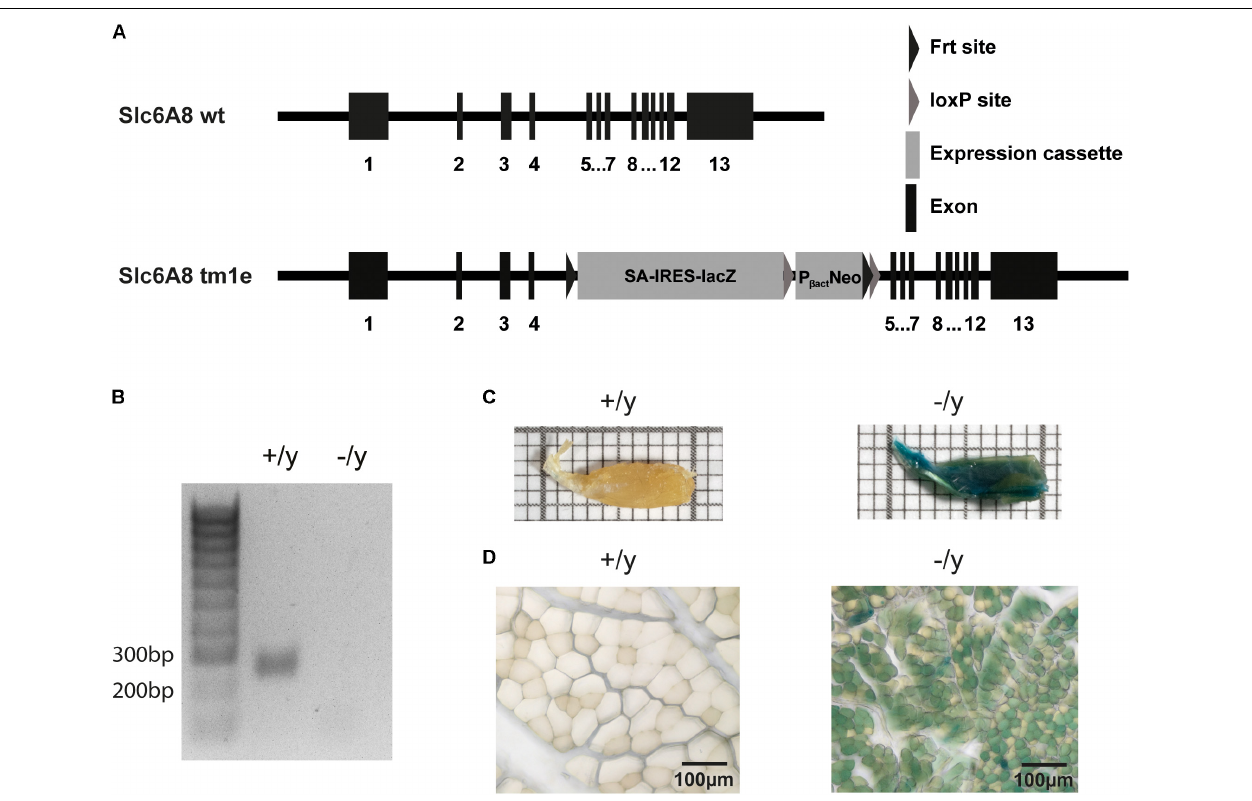
FIGURE 1 | Generation and characterization of CT1-deficient mice. (A) The CT1 gene was disrupted by insertion of a SA-IRES-lacZ-neomycin cassette (tm1e allele). (B) Total RNA prepared from muscle of CT1 + / y and CT1 − / y mice was reverse transcribed and then used for PCR amplification with primers specific for CT1 (expected band size: 250 bp). No amplification product for CT1 was observed in knockout mice. (C,D) Macroscopic (on a mm grid scale) and microscopic view of hind limb muscle after LacZ staining indicating CT1 promoter activation.